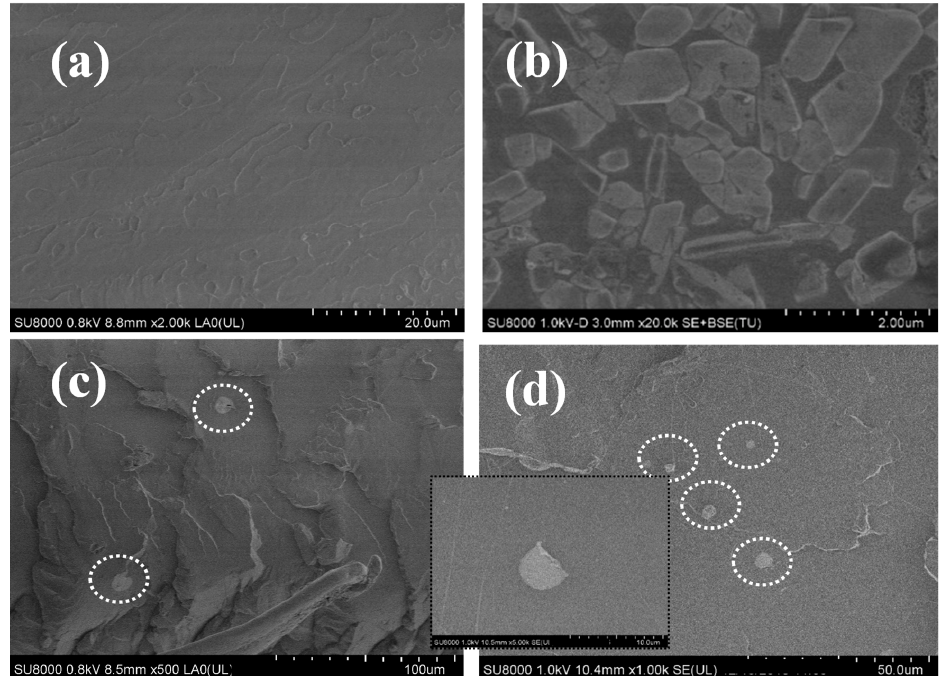
Figure 1. SEM micrographs of ( a ) poly( L -lactic acid) (PLLA), ( b ) tungsten disulfide nanosheets (2D-WS 2 ) and PLLA/2D-WS 2 nanocomposites with nanofiller loadings of ( c ) 0.5 and ( d ) 1.0 wt %. The white dashed circles represented the 2D-WS 2 .